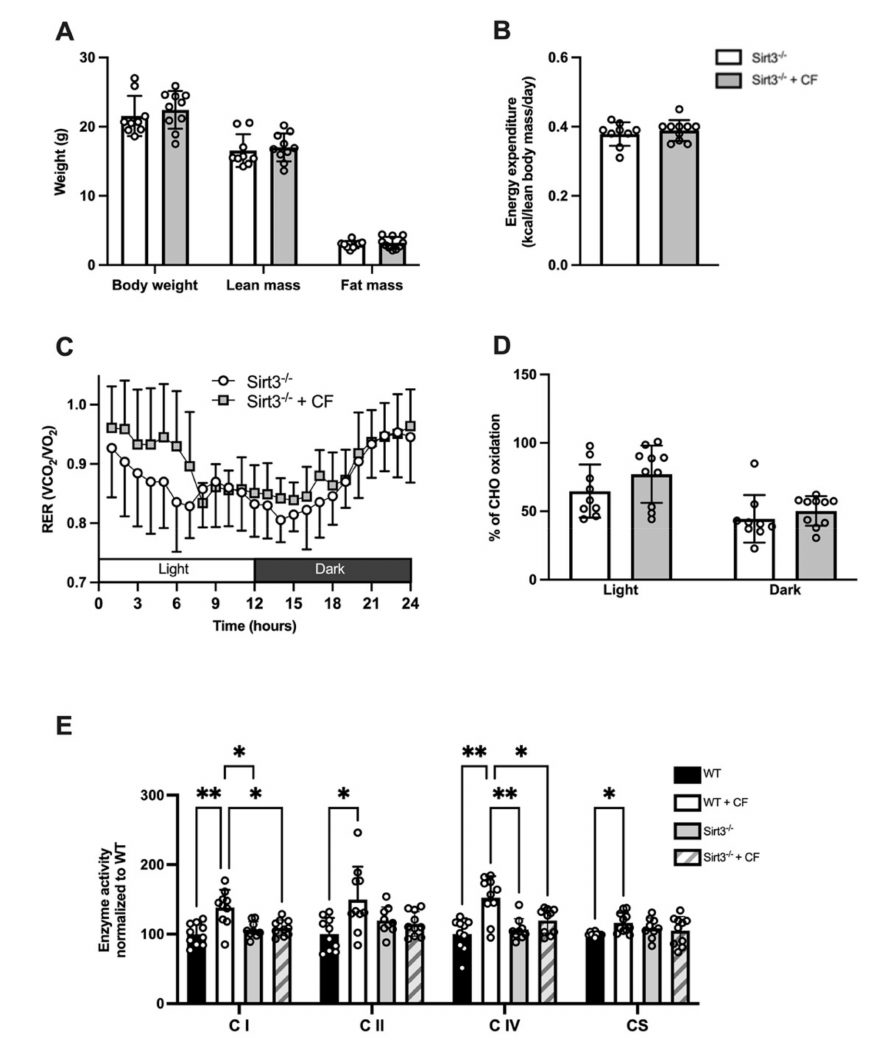
Figure 6. Impact of 15 days of CF supplementation on whole-body and mitochondrial metabolism of Sirt3 -/- mice. ( A ) Body weight, lean mass, and fat mass. ( B ) Daily energy expenditure. ( C ) Respiratory exchange ratio (RER) over a 24 h cycle. ( D ) Carbohydrate and fat oxidation in light and dark cycles. ( E ) Enzyme activities of respiratory chain complexes and citrate synthase in the white gastrocnemius muscle. n = 10 in the control group and n = 9 in the Sirt3 -/- group, means ± SD, * p < 0.05, ** p <